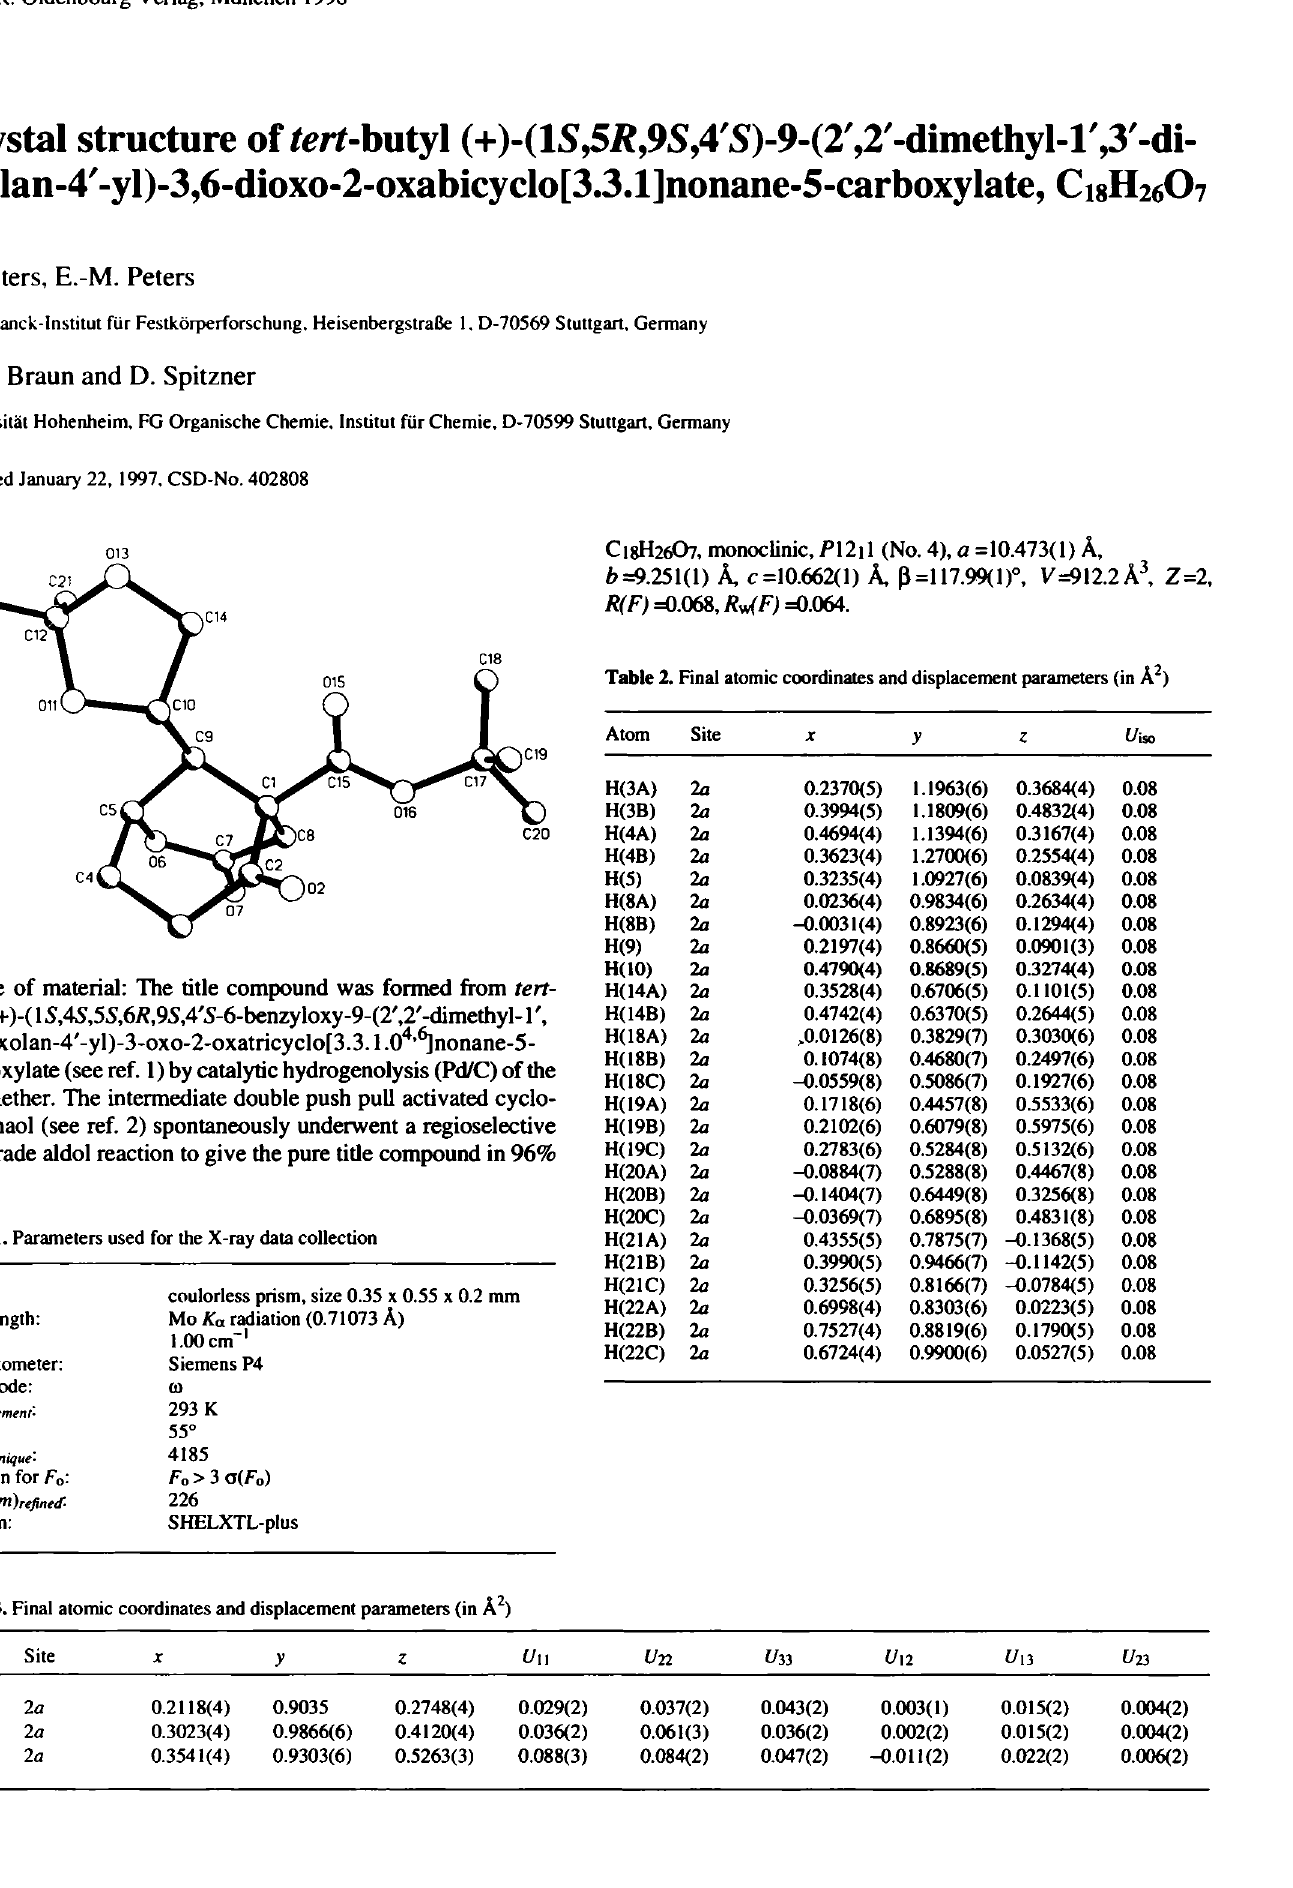
Table 1. Parameters used for the X-ray data collection Crystal: